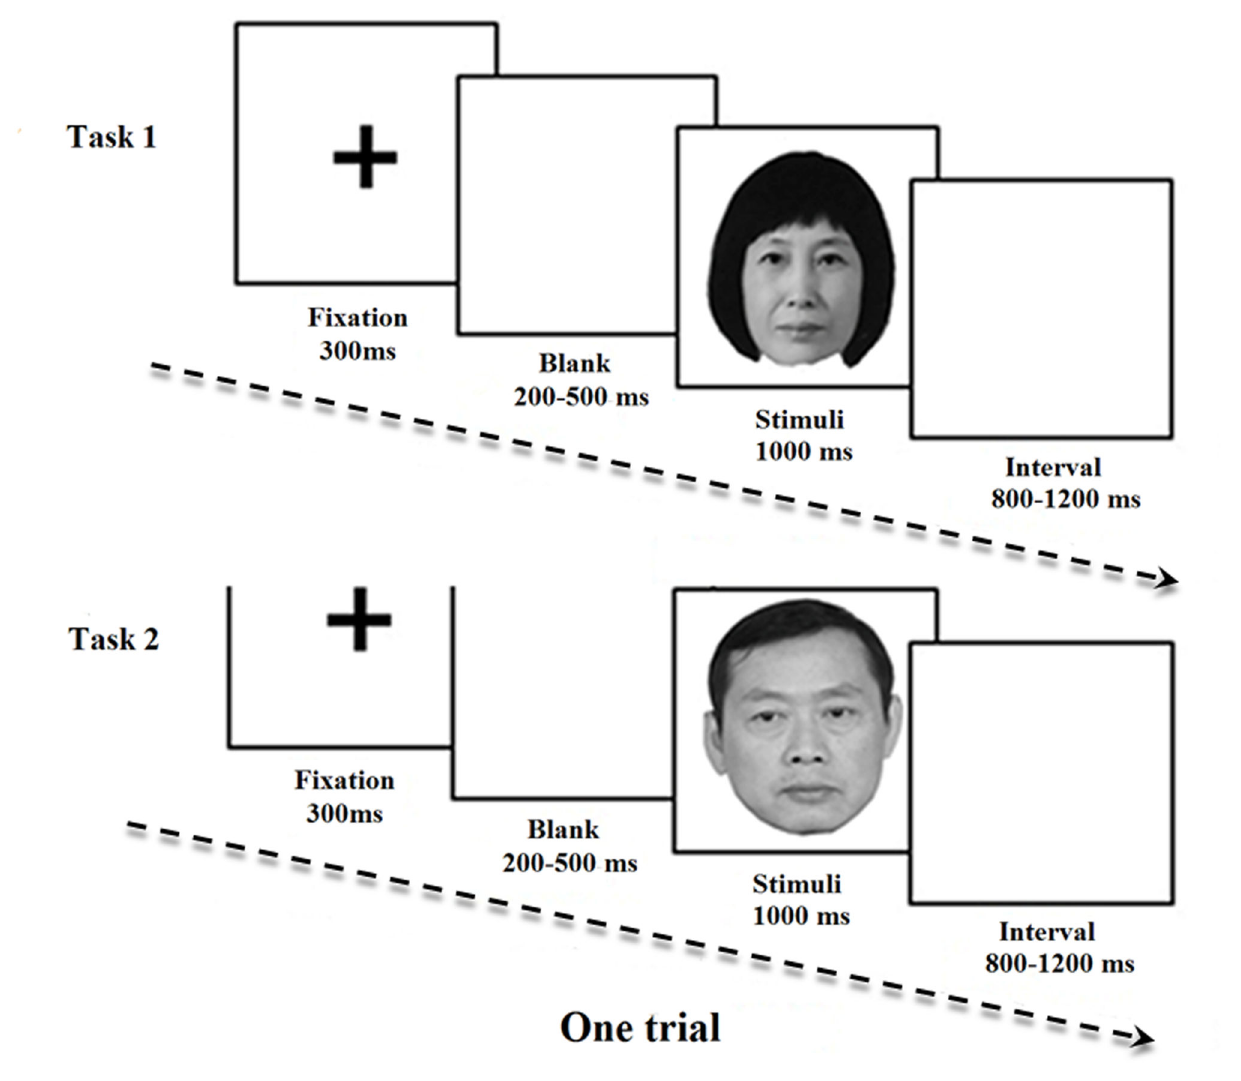
Figure 1. Recording procedure and an example of the facial stimuli. In each trial, the participants were asked to respond as soon as their parents’ faces were presented and to ignore male/female strangers’ faces. All of the participants were asked to finish two single oddball tasks, and the task order was balanced across the participants. The parents whose photographs are presented here have given written informed consent, as outlined in the PLOS consent form, permitting us to publish, reuse and reprint their